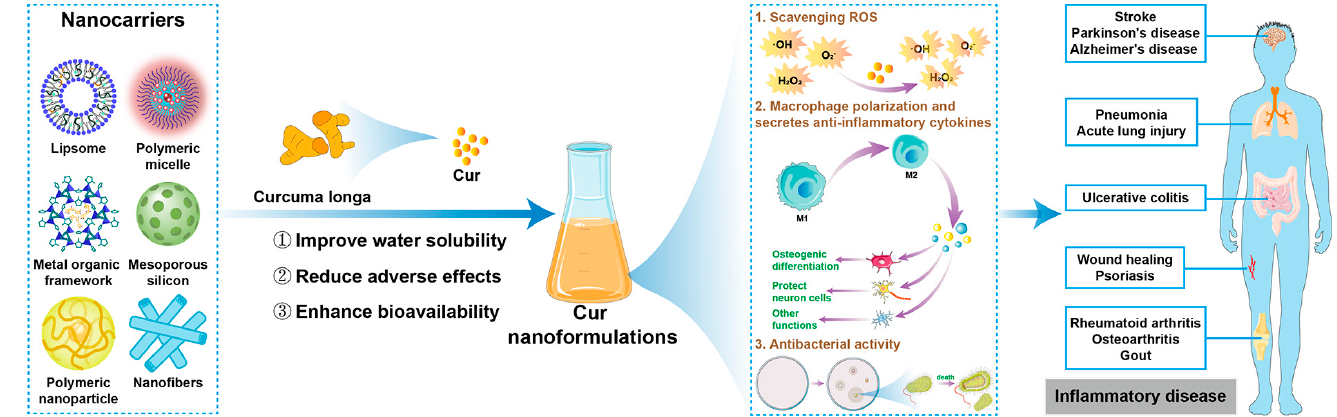
Figure 1. Schematic diagram of the preparation of Cur nanoformulations and their therapeutic application in inflammatory diseases. Table 1. Representative types, compositions, physical properties, and functionalization modifica- tions of various Cur nanoformulations.